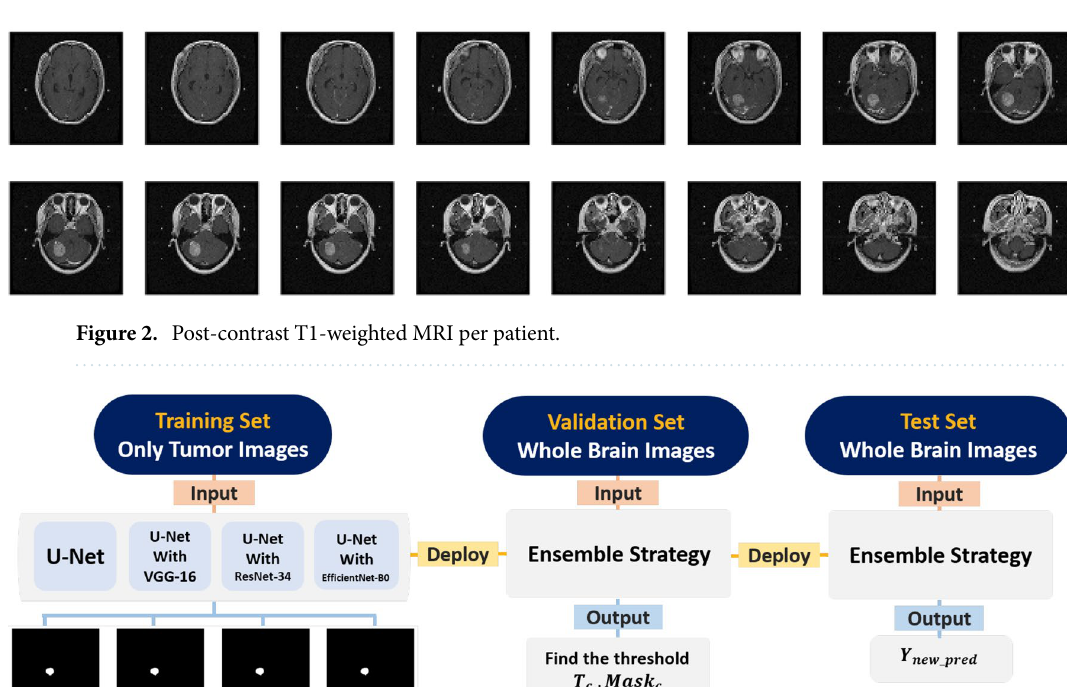
Figure 3. The framework of the experimental design in this